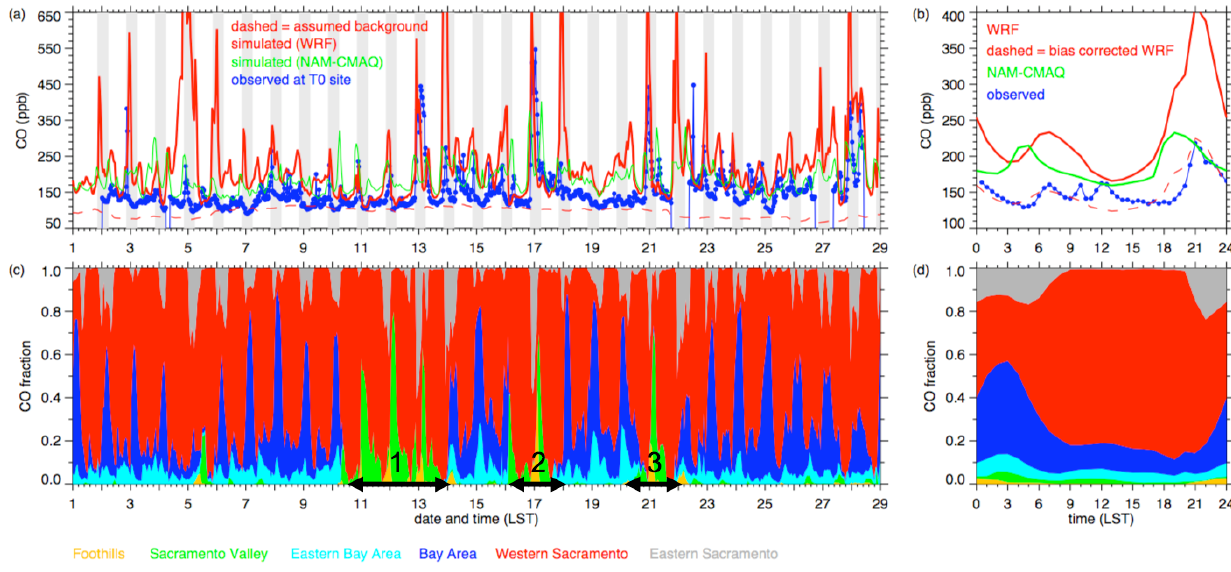
Figure 14. (a) Observed and simulated CO at the T0 site in Sacramento and (b) average diurnal variation in CO during June 2010. In (a) gray shading in denotes nighttime periods and the dashed red line is the derived background CO mixing ratio described in text. (c) Relative contribution of each source region to the simulated CO mixing ratios at the T0 site and (d) average diurnal variation of CO from each source region during June 2010. Arrows denote three periods of northwesterly synoptic flow.